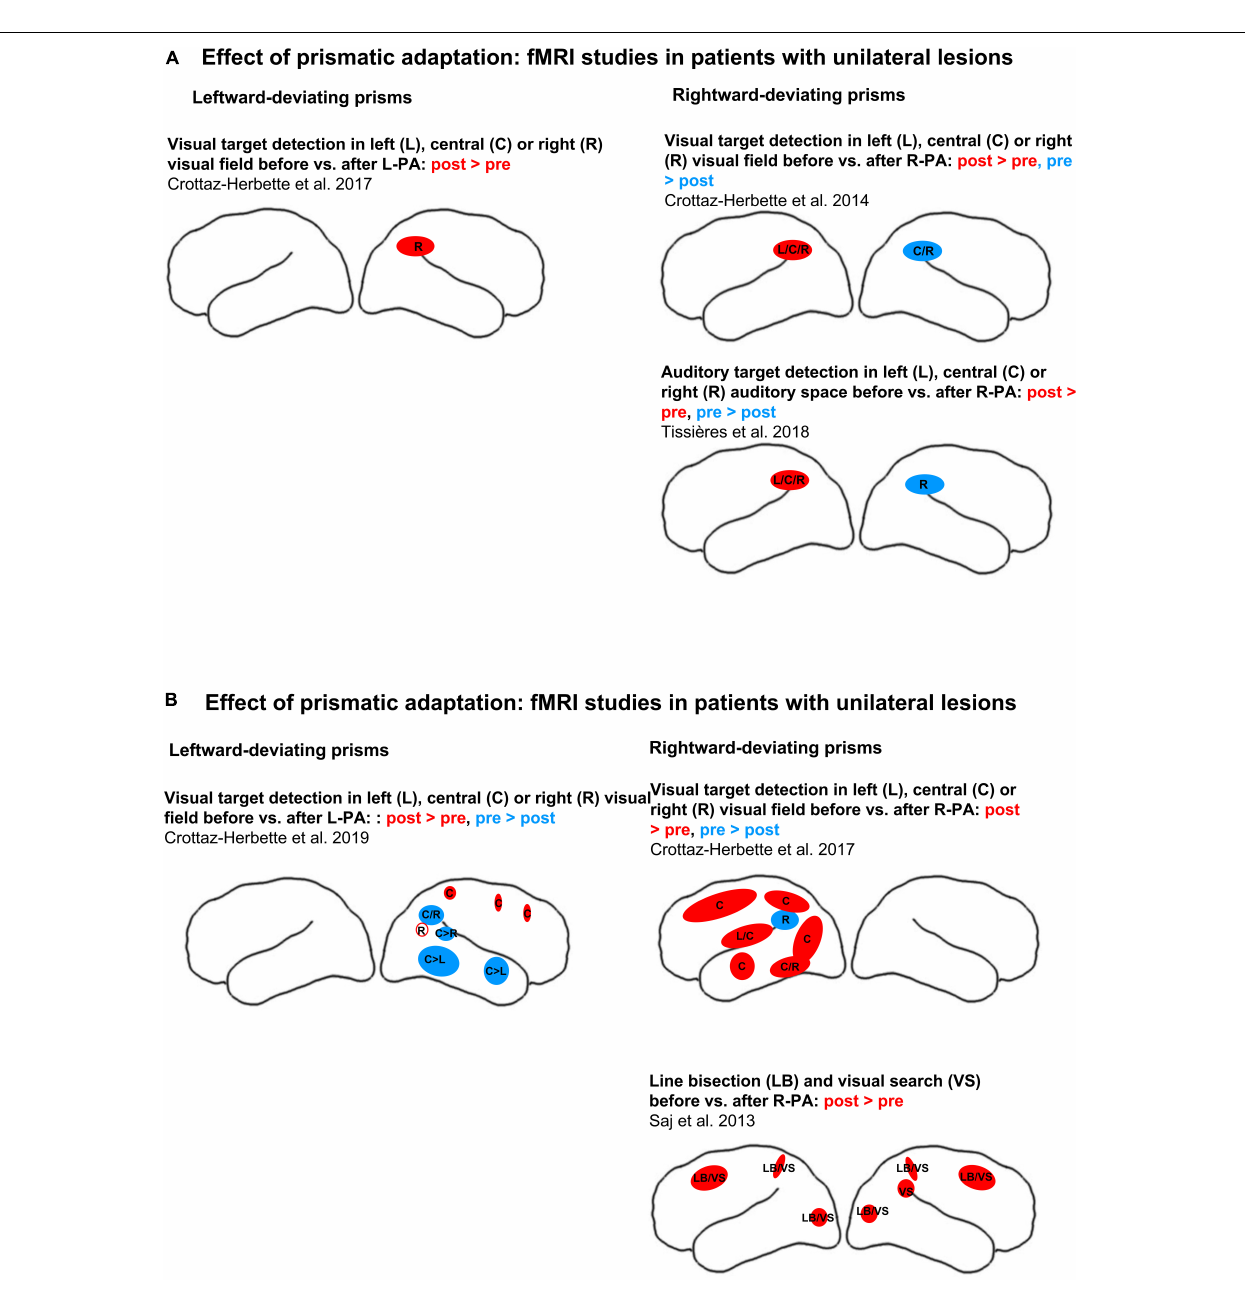
FIGURE 2 | Effects of adaptation to left-deviating (left column) or right-deviating prisms (right column), as demonstrated with fMRI paradigms. (A) Changes of activity elicited by visual target detection before vs. after prismatic adaptation in normal subjects. (B) Changes of activity elicited by visual target detection (top row) or by line bisection and visual search before vs. after prismatic adaptation (bottom row) in patients with left or right unilateral hemispheric lesions (left and right columns, respectively). Red and blue denote, respectively, increases and decreases of activity when comparing early vs. late stages of adaptation or pre- vs. post-adaptation sessions. Filled circles and ellipses mark cluster of activity on the convexity, empty ones those in sulci or on the medial part of the hemisphere. L, C, and R denote, respectively, left, central, and right stimulus position in target detection paradigms. LB denotes line bisection, VS visual